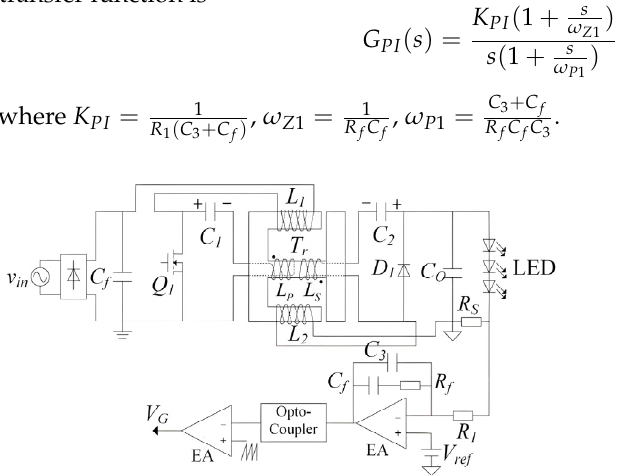
Figure 6. Proposed circuit with type II feedback